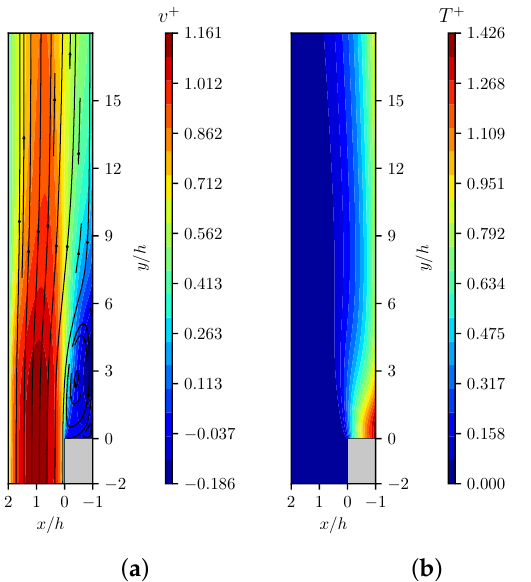
Figure 8. Velocity streamlines with contour of the non-dimensional streamwise velocity v + = v / U b ( a ) and contour of the non-dimensional temperature T + = ( T